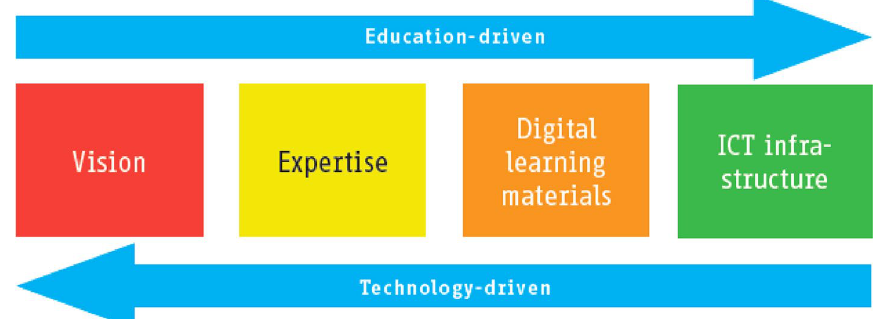
Fig. 1 “Education-driven” versus “technology-driven” innovation in ICT (Source: Kennisnet (2011, p. 11, as Figure 1.2 in the